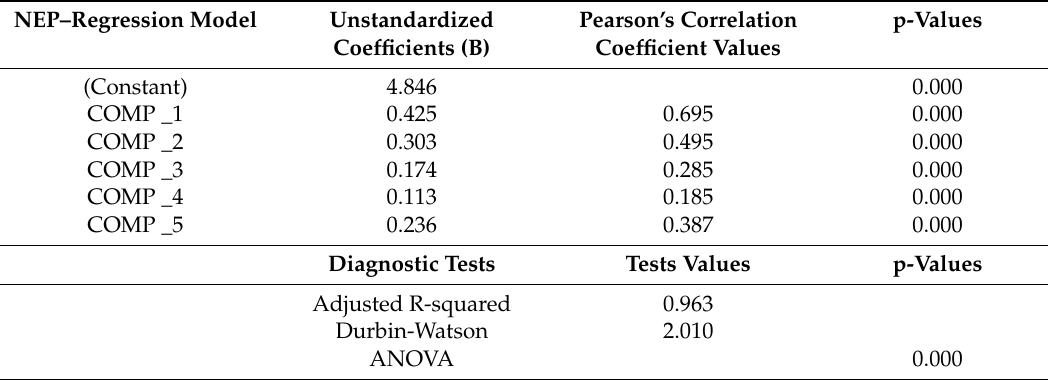
Table 5. Multiple linear regression model for the New Environmental Paradigm Scale (NEP) mean score, coefficients and diagnostic tests.